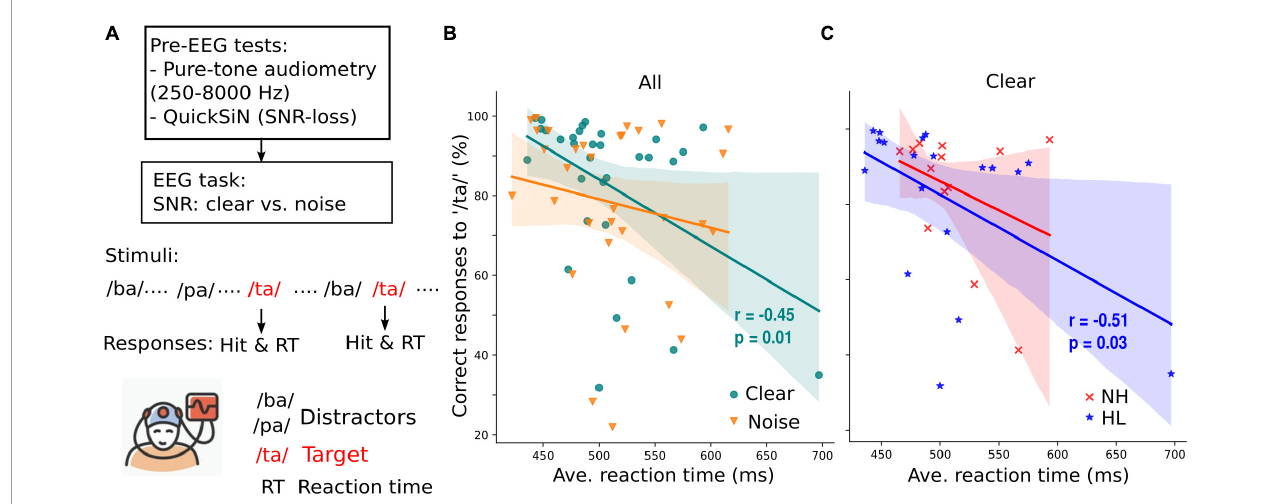
FIGURE1 Target speech detection performance correlates with average response time collected during an active EEG task. (A) Prior to EEG recordings, all participants’ pure-tone audiometry tested at 250–8,000 Hz were obtained and speech-in-noise perception was assessed with QuickSiN. Subsequently, speech-EEGs to consonant-vowel phonemes (/ba/, /pa/, and /ta/) were recorded under clear or noisy (+10 dB SNR) backgrounds while participants actively engaged in the target speech detection task. (B) Correct responses to target speech (i.e., /ta/) are predictive of reaction times in quite (clear) but not noisy backgrounds. (C) When participants were divided into normal (NH) and hearing loss (HL) groups, the correlation of speech detection accuracy and reaction time obtained in quiet backgrounds is significant only in the HL group. r = Spearman’s correlation; shaded area = 95% CI of the regression